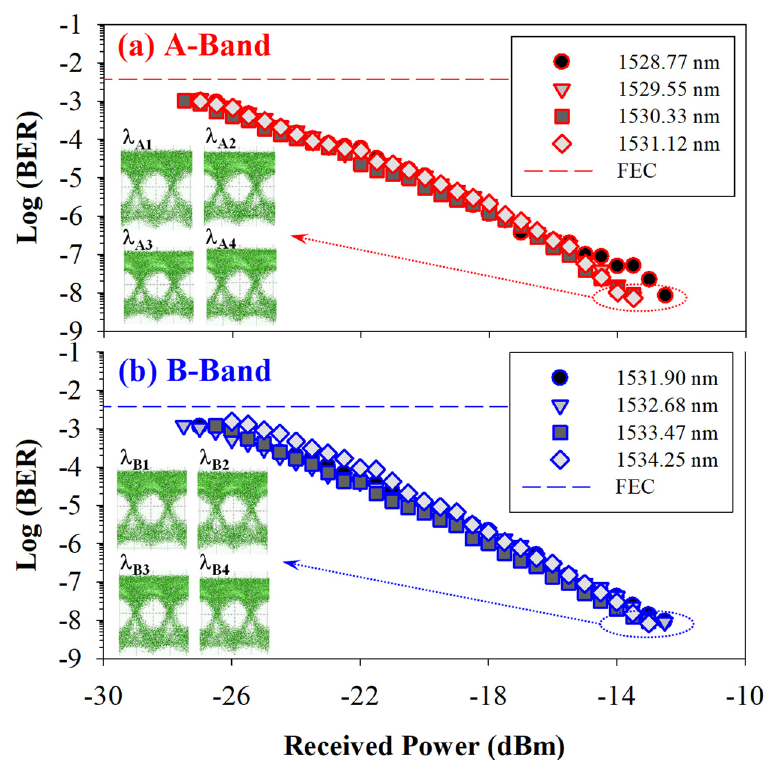
Figure 6. Measured 24.3 Gbit/s BER performances of λ A1D to λ A4U in original WDM fiber path through 24 km link. ( b ) Obtained BER measurements of λ B1D to λ B4U via the same fiber path after 25 km fiber connection. Insets are the corresponding eye diagrams of eight selected wavelengths.